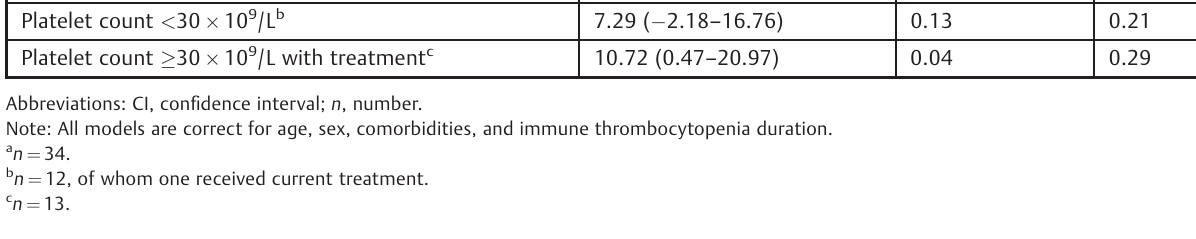
Table 2 The relation between fatigue and disease activity High disease activity vs. low disease activity